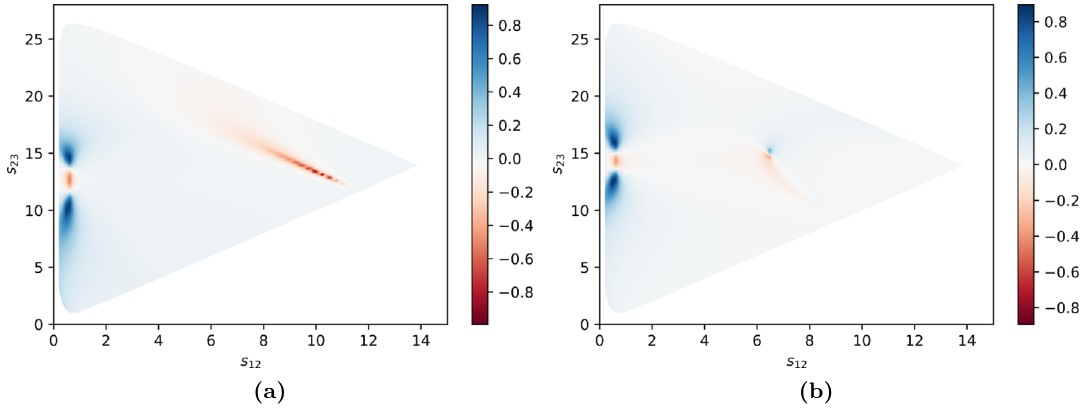
Figure 5. CP distributions from interference of a (cid:26) resonances and Breit-Wigner parametrizations (a) for the S -wave resonance (cid:31) c 0 (3860) (b) the P -wave resonance X